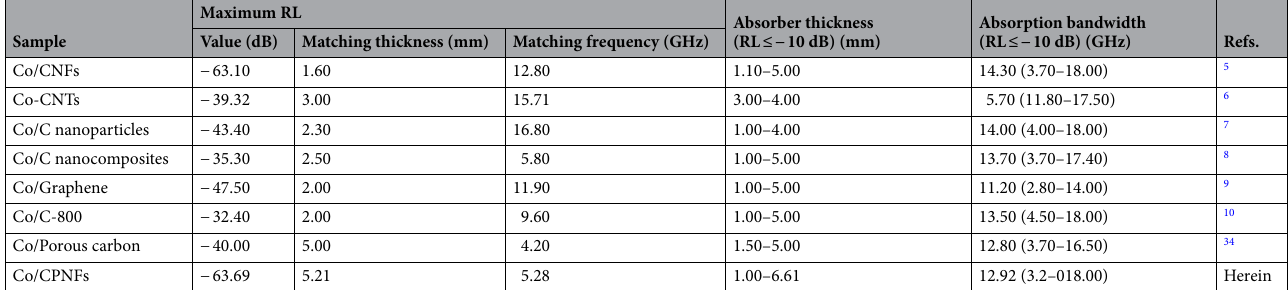
Table 2. Microwave absorption performance of various typical Co-based